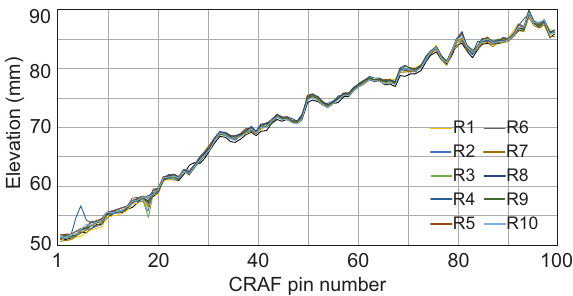
Fig. 7 Results of repeat measurements along transect line D4 at CRAM site 4 to evaluate instrument repositioning errors. Location of site shown in Supplementary Fig.